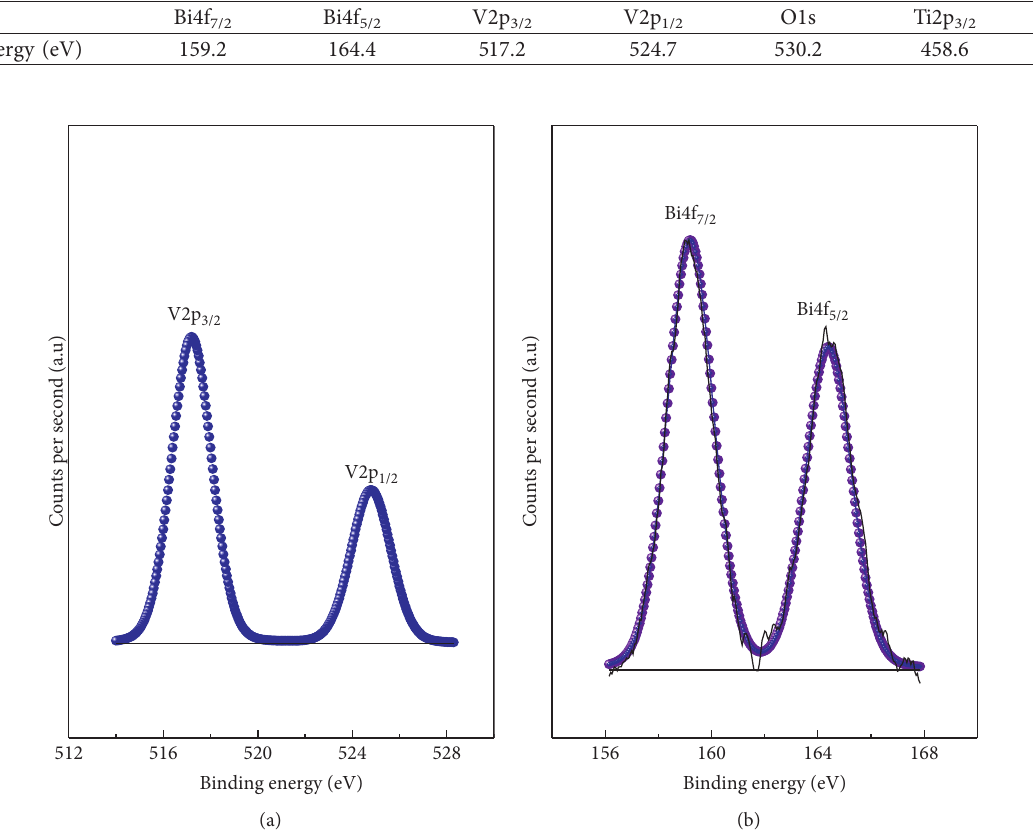
Table 3: Binding energies (eV) of core levels of 2 wt% BiVO